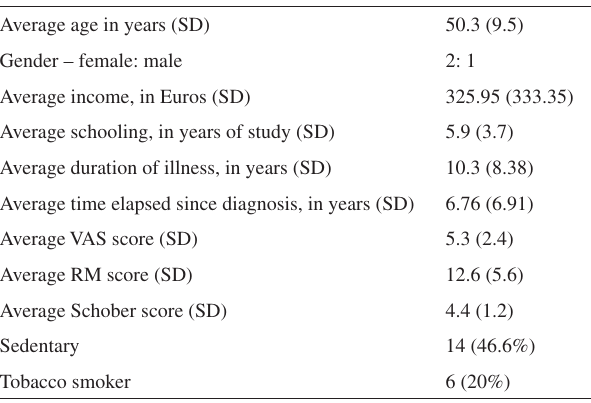
Table 1 – Clinical, demographic and socioeconomic charac- teristics of patients with low back pain